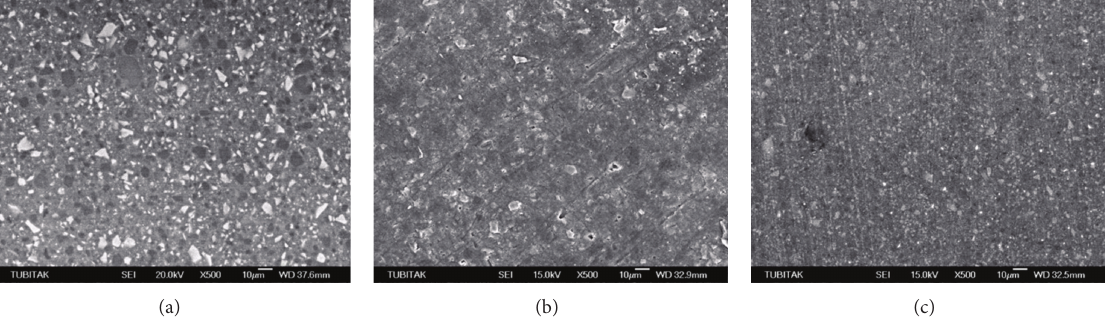
Figure 1: (a) Scanning electron micrograph of TES-C showing a homogenous distribution of different kind of filler particles. (b) TES-DT group presented scratch lines and some debonding of filler particles while TES-TP group revealed smooth scratch lines without debonding of fillers particles (c).